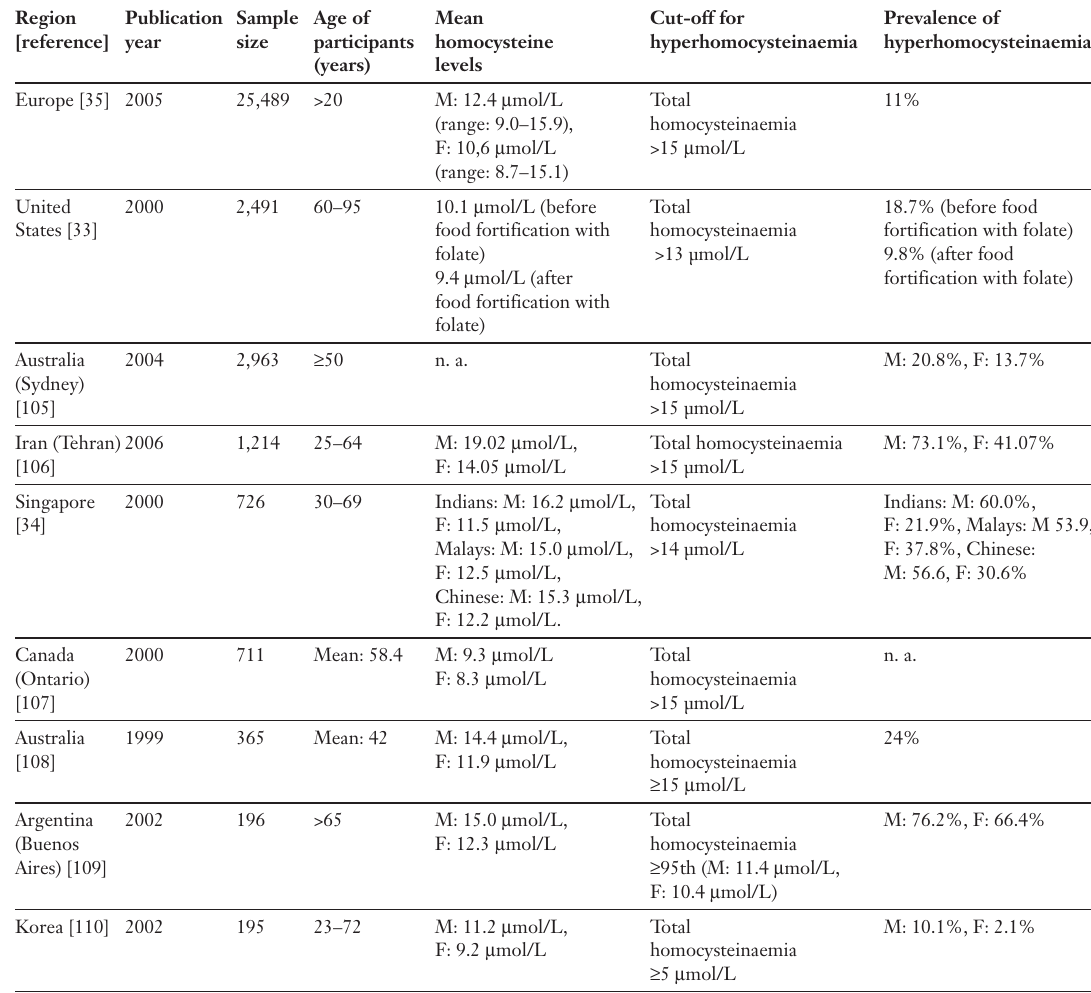
Table 2 Mean homocysteine levels and prevalence of hyperhomocys- teinaemia in different populations.